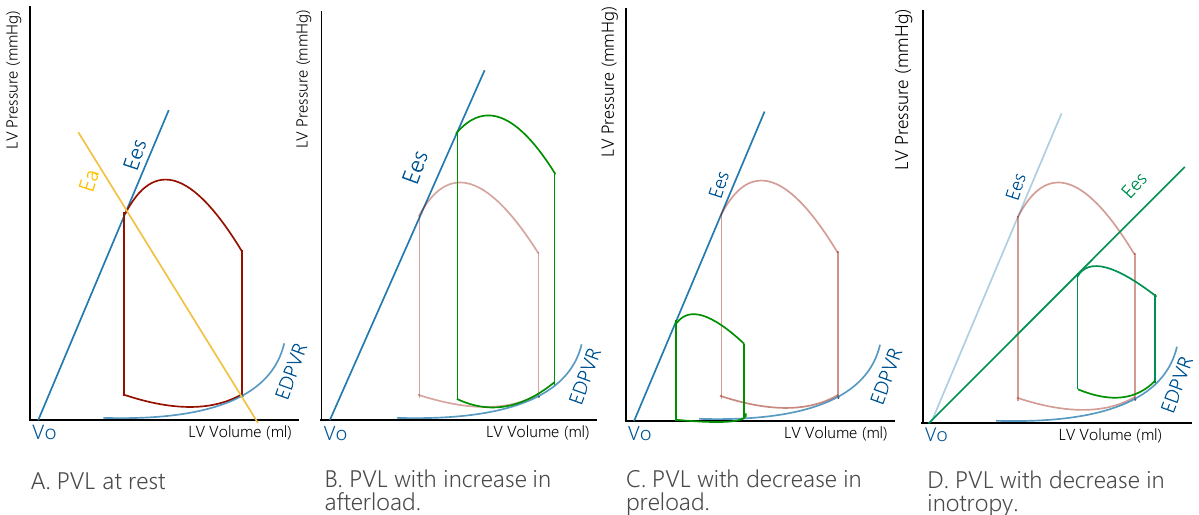
Figure 1. Various interventions on the PVL loop. A. LV PVL at rest; B. Increase in afterload (the PVL changes to the right and upwards); C. Decrease in preload (the PVL changes to the left and downwards); D. Decrease in inotropism (the PVL will change downwards and to the